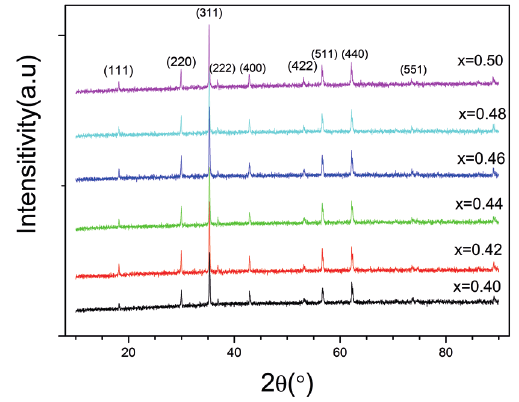
Figure 2: X-ray diffraction (XRD) patterns of the ferrites with different compositions.